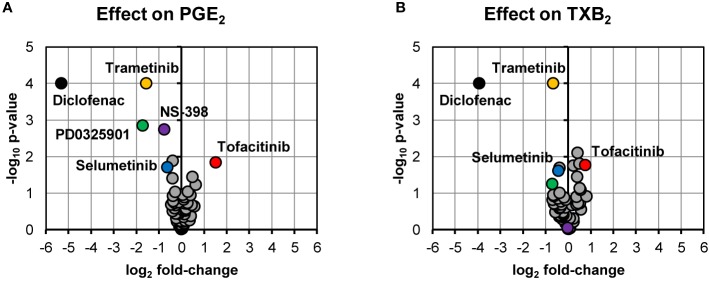
Volcano plots showing effects on PGE2
(A) and TXB2
(B) production in LPS-induced human whole blood. The top altered conditions compared to vehicle control based on fold-change (< 0.5 or >2) and p-value (< 0.05) are highlighted. Each inhibitor was tested in 4–15 donors. Statistical significance was tested using one-sample t-test (p < 0.05). PGE2, prostaglandin E2; LPS, lipopolysaccharide; TXB2, thromboxane B2.